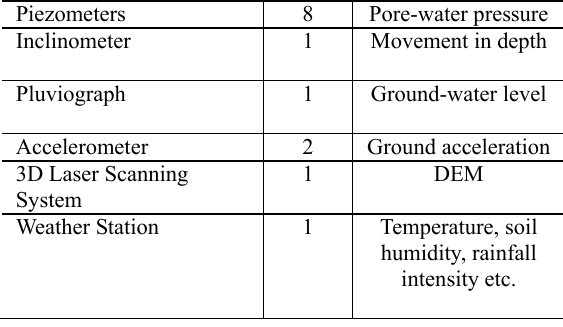
Table 1. The equipment used for landslide monitoring caused